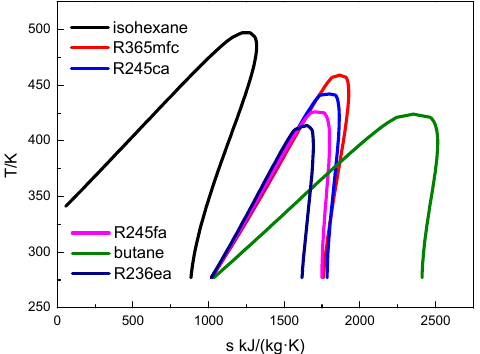
Figure 3. The T–s plots of working fluids.